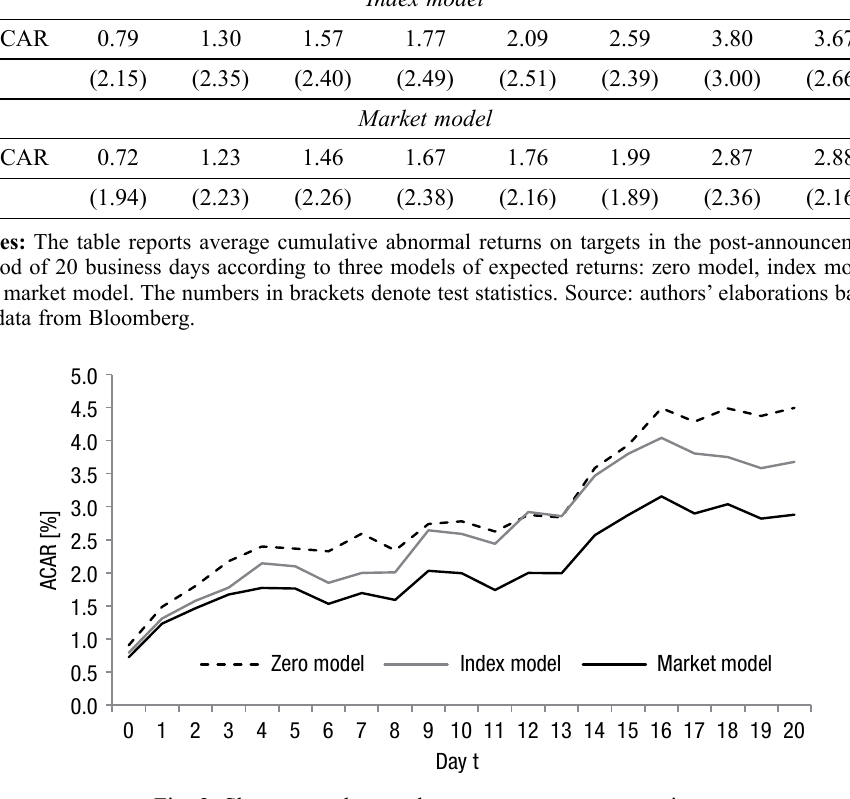
Fig. 2. Short-term abnormal returns on target